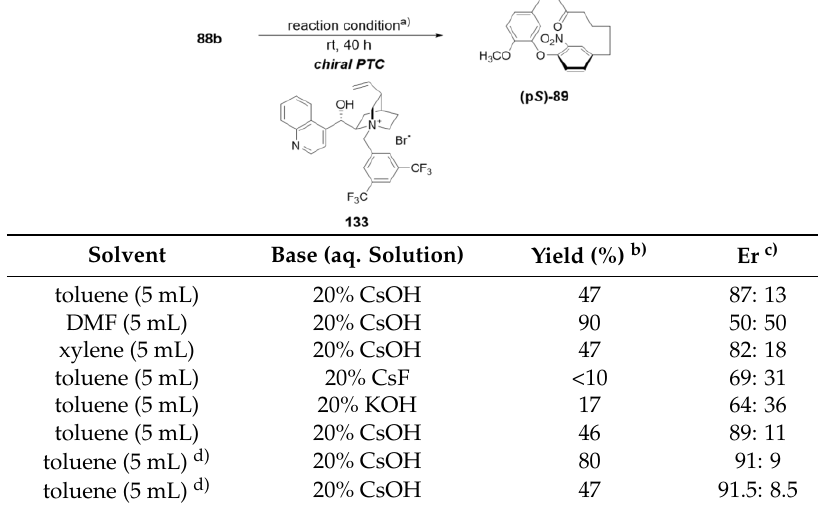
Table 8. Screening reaction conditions for cyclization of linear diarylheptanoid 88b .